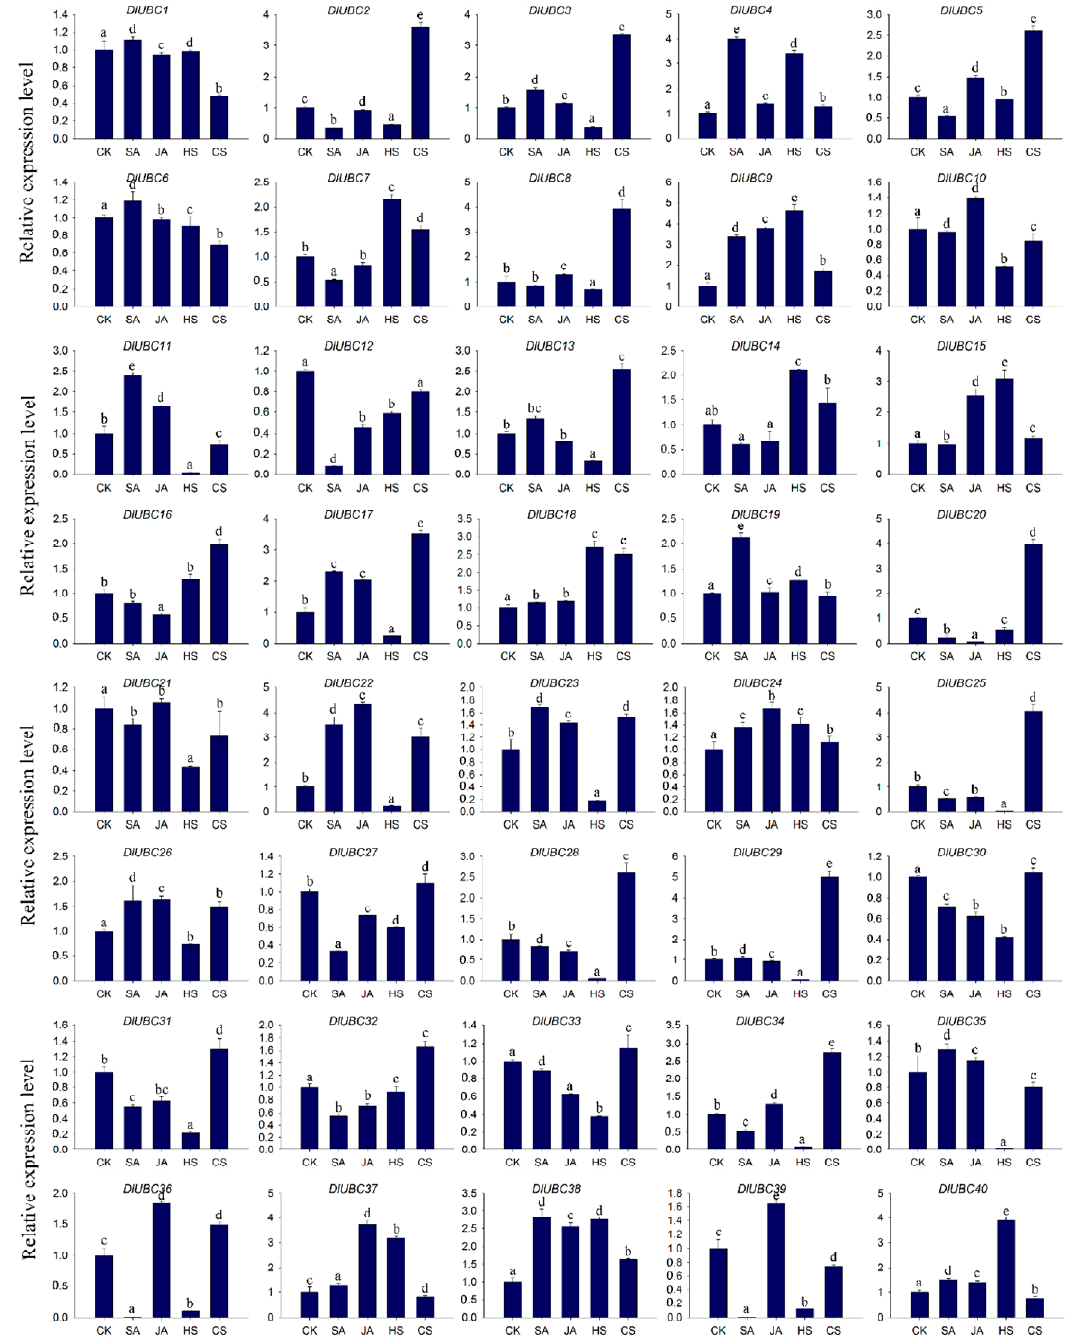
Figure 6. Expression patterns of DlUBC genes under various hormonal and abiotic stresses. The x-axis indicates various treatments and the y-axis indicates the relative gene expression level. Error bars indicating SD were obtained from three independent biological replicates. Values with the same letter were not significantly different when assessed using Duncan’s multiple range test ( p < 0.05, n = 3). SA = salicylic acid, JA = jasmonic acid, HS = heat stress, and CS = cold stress.